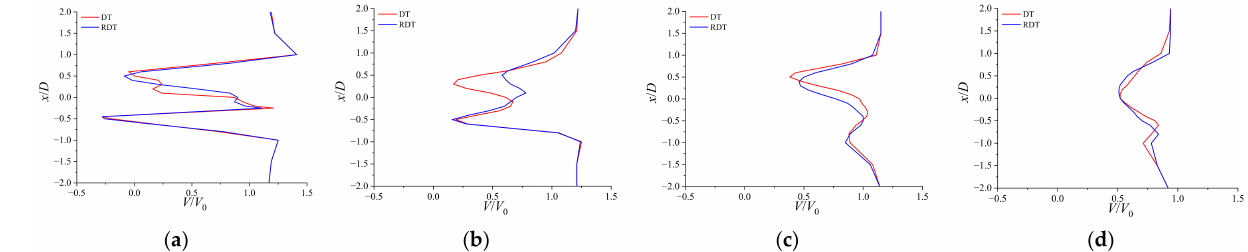
Figure 20. Profiles of mean streamwise velocity for γ = 40 ◦ at different streamwise locations in the central x - z plane: ( a ) z / D = 0.5; ( b ) z / D = 1.0; ( c ) z / D = 3.0; ( d ) z / D = 5.0.